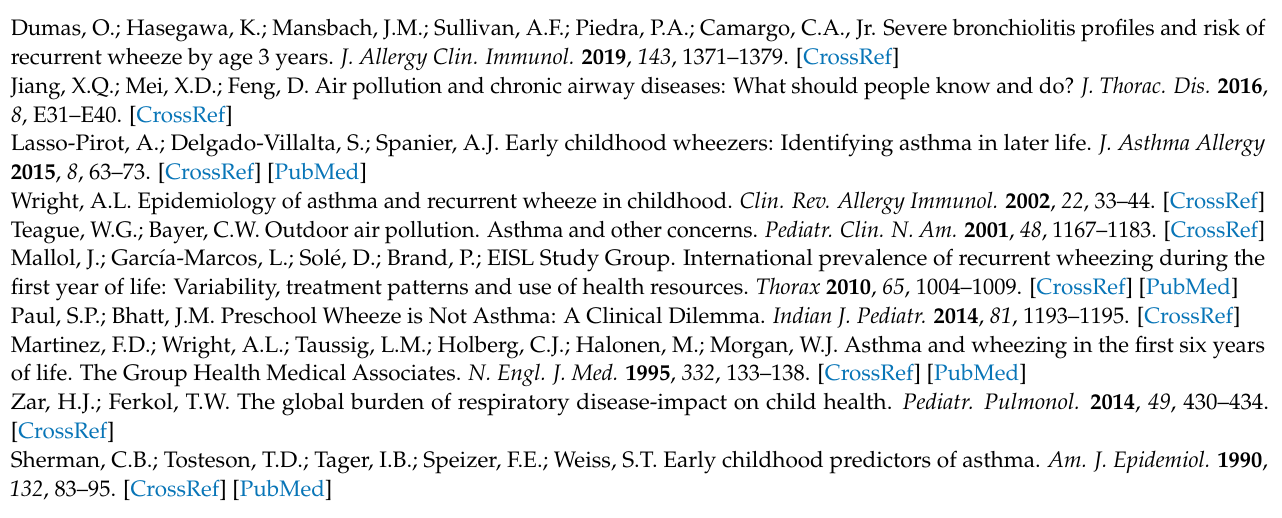
Table S2: Adjusted logistic regression models of road exposures for combined outcomes of recurrent wheeze by age 3 years and asthma by age 5 years, Figure S1: Recurrent wheeze incidence rate per 100,000 people with distance to major road from birth address ≤ 4000 m, Figure S2: Recurrent wheeze incidence rate per 100,000 people with pooled distance to major road ≤ 4000 m, Figure S3: Distribution of major and primary roads across